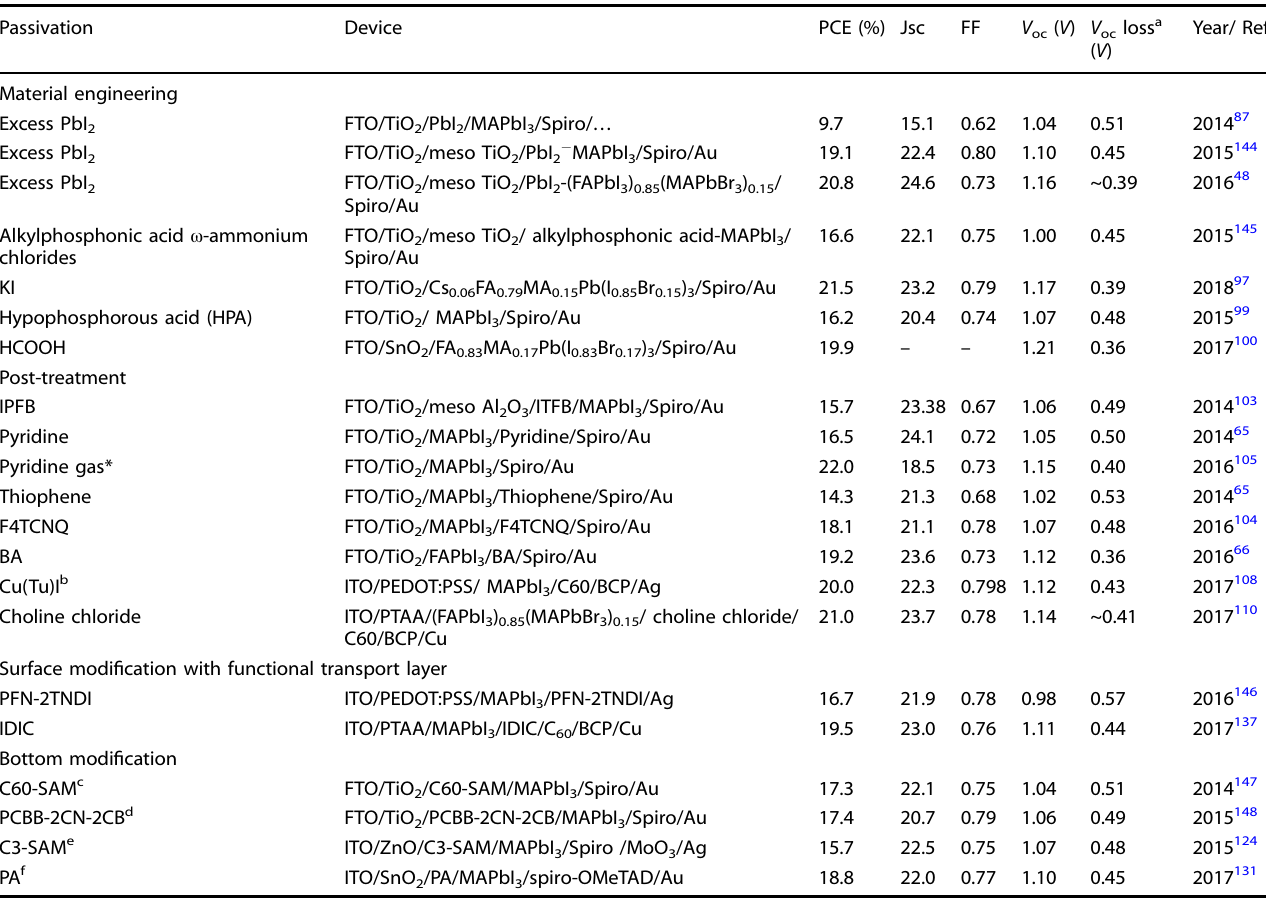
Table 2. Summary of surface/bottom passivation and corresponding photovoltaic performance